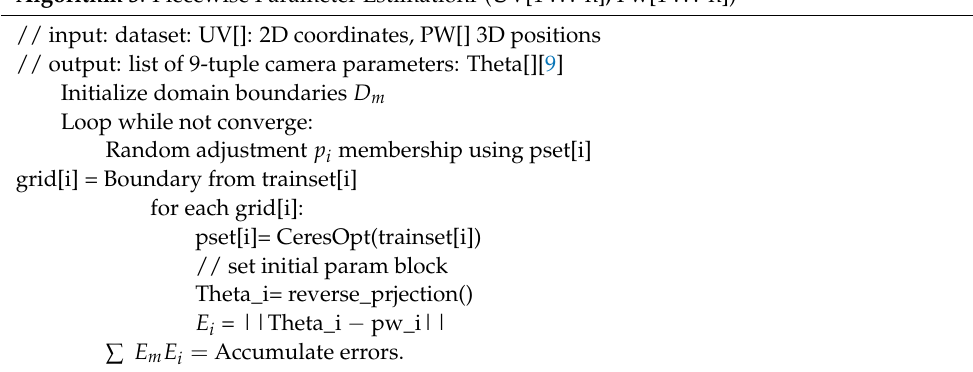
Algorithm 3 : Piecewise Parameter Estimationr (UV[1 . . . n], Pw[1 . . .